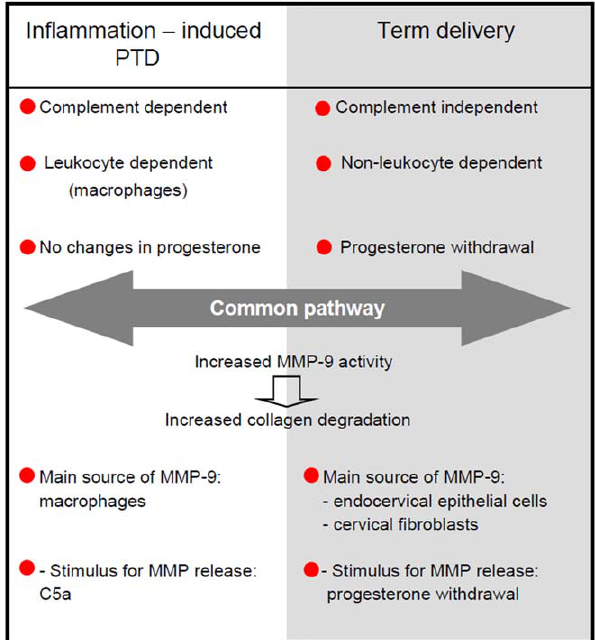
Figure 5. Distinct and similar features during preterm and term cervical remodeling. PTD is initiated by complement activation while complement activation is not required for term parturition. In addition term delivery was found to be non-leukocyte dependent while on the other hand preterm delivery is mediated by macrophages. A dramatic diminution in serum progesterone levels precedes parturition at term but no progesterone levels changes are observed in PTD. PTD and term delivery share a common dowsntream pathway characterized by increased MMPs release and increased collagen degradation. The sources of MMPs in PTD are macrophages while cervical stromal fibroblasts and columnar epithelial cells seem to be the source of MMPs at term. Anaphylotoxin C5a is the trigger for MMPs release in PTD while progesterone withdrawal seems to be the trigger at term. In conclusion, preterm and term cervical remodeling occur through the same mechanism but it is initiated by different triggers and effector cells.